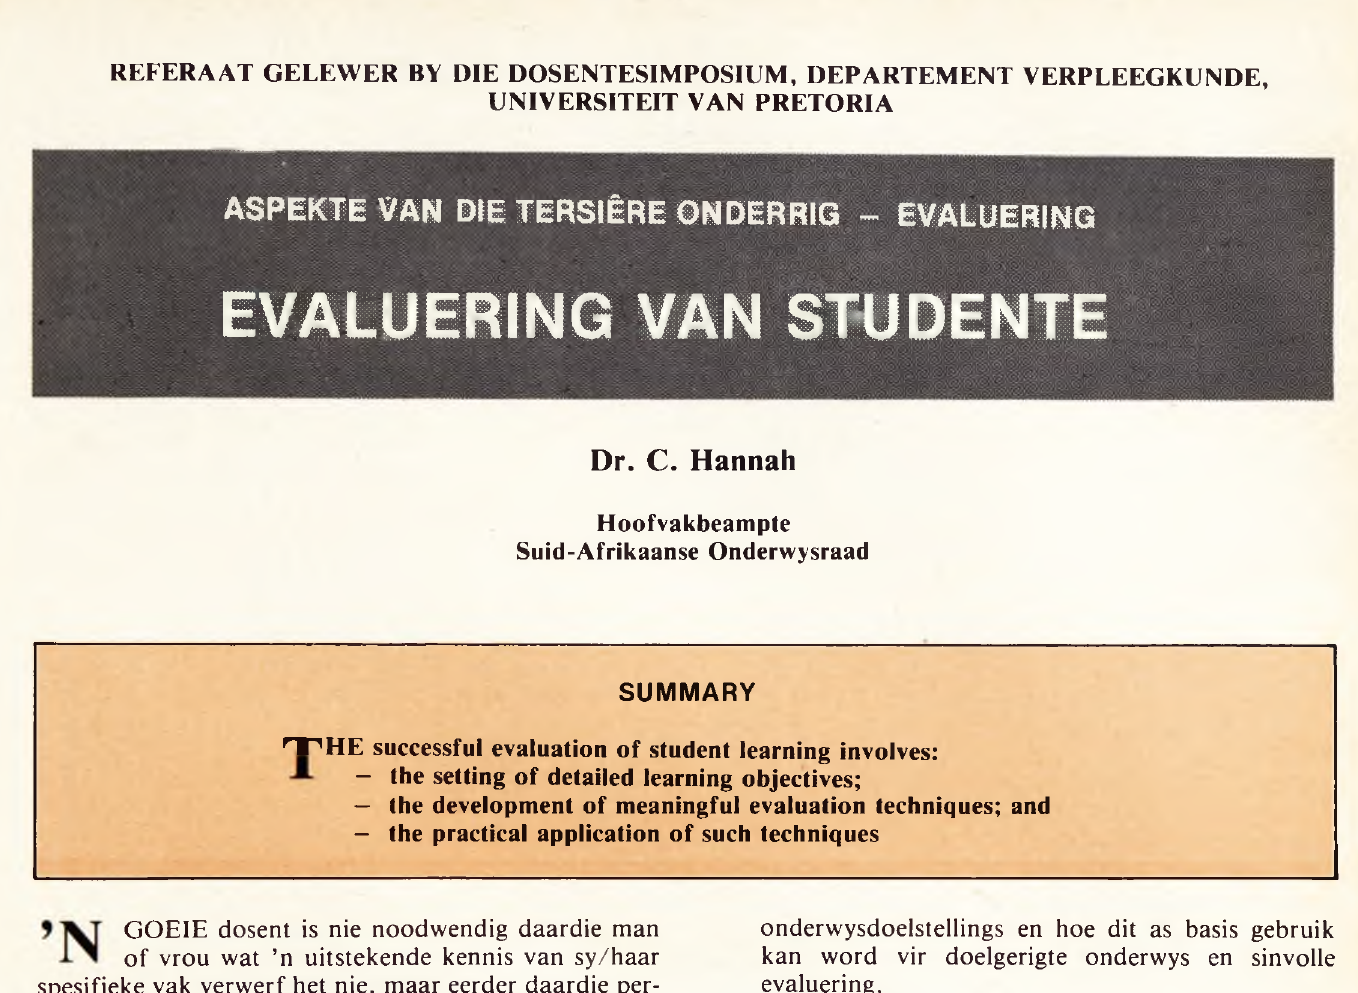
REFERAAT GELEWER BY DIE DOSENTESIMPOSIUM, DEPARTEMENT